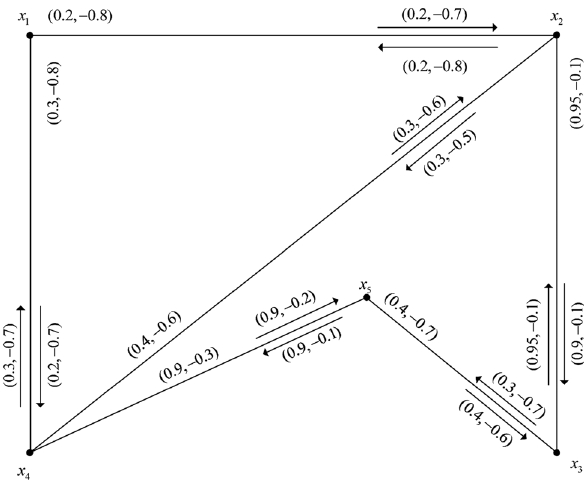
Figure 3: A partial bipolar fuzzy incidence subgraph